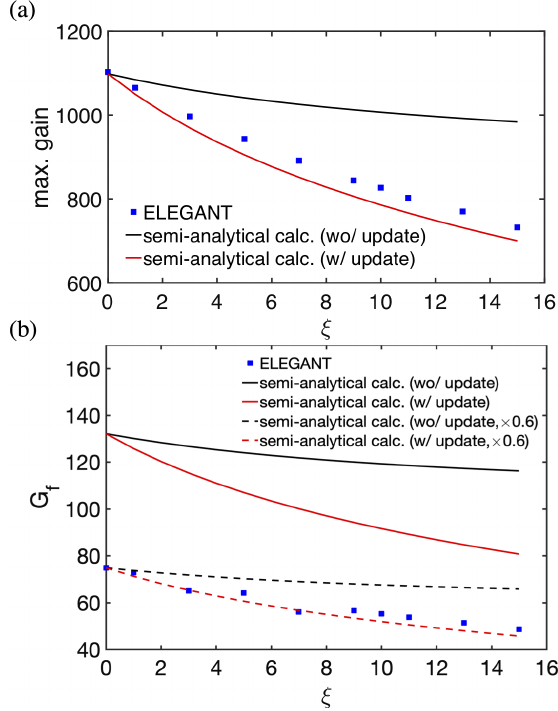
FIG. 9. Dependence of (a) the maximum gain and (b) the final gain on the IBS enhancement factor ξ . Only the steady-state CSR is included in the calculation. The solid lines are from semianalytical calculations and the square dots from ELEGANT tracking simulations. The black and red solid lines are, respec- tively, without and with update of σ δ and ϵ due to IBS along the x;y beamline. The black and red dashed lines in (b) are 0.6 times their corresponding solid lines. It can be seen that the red lines match well with the particle tracking results. For detailed discussion of the dashed lines, see comments in the